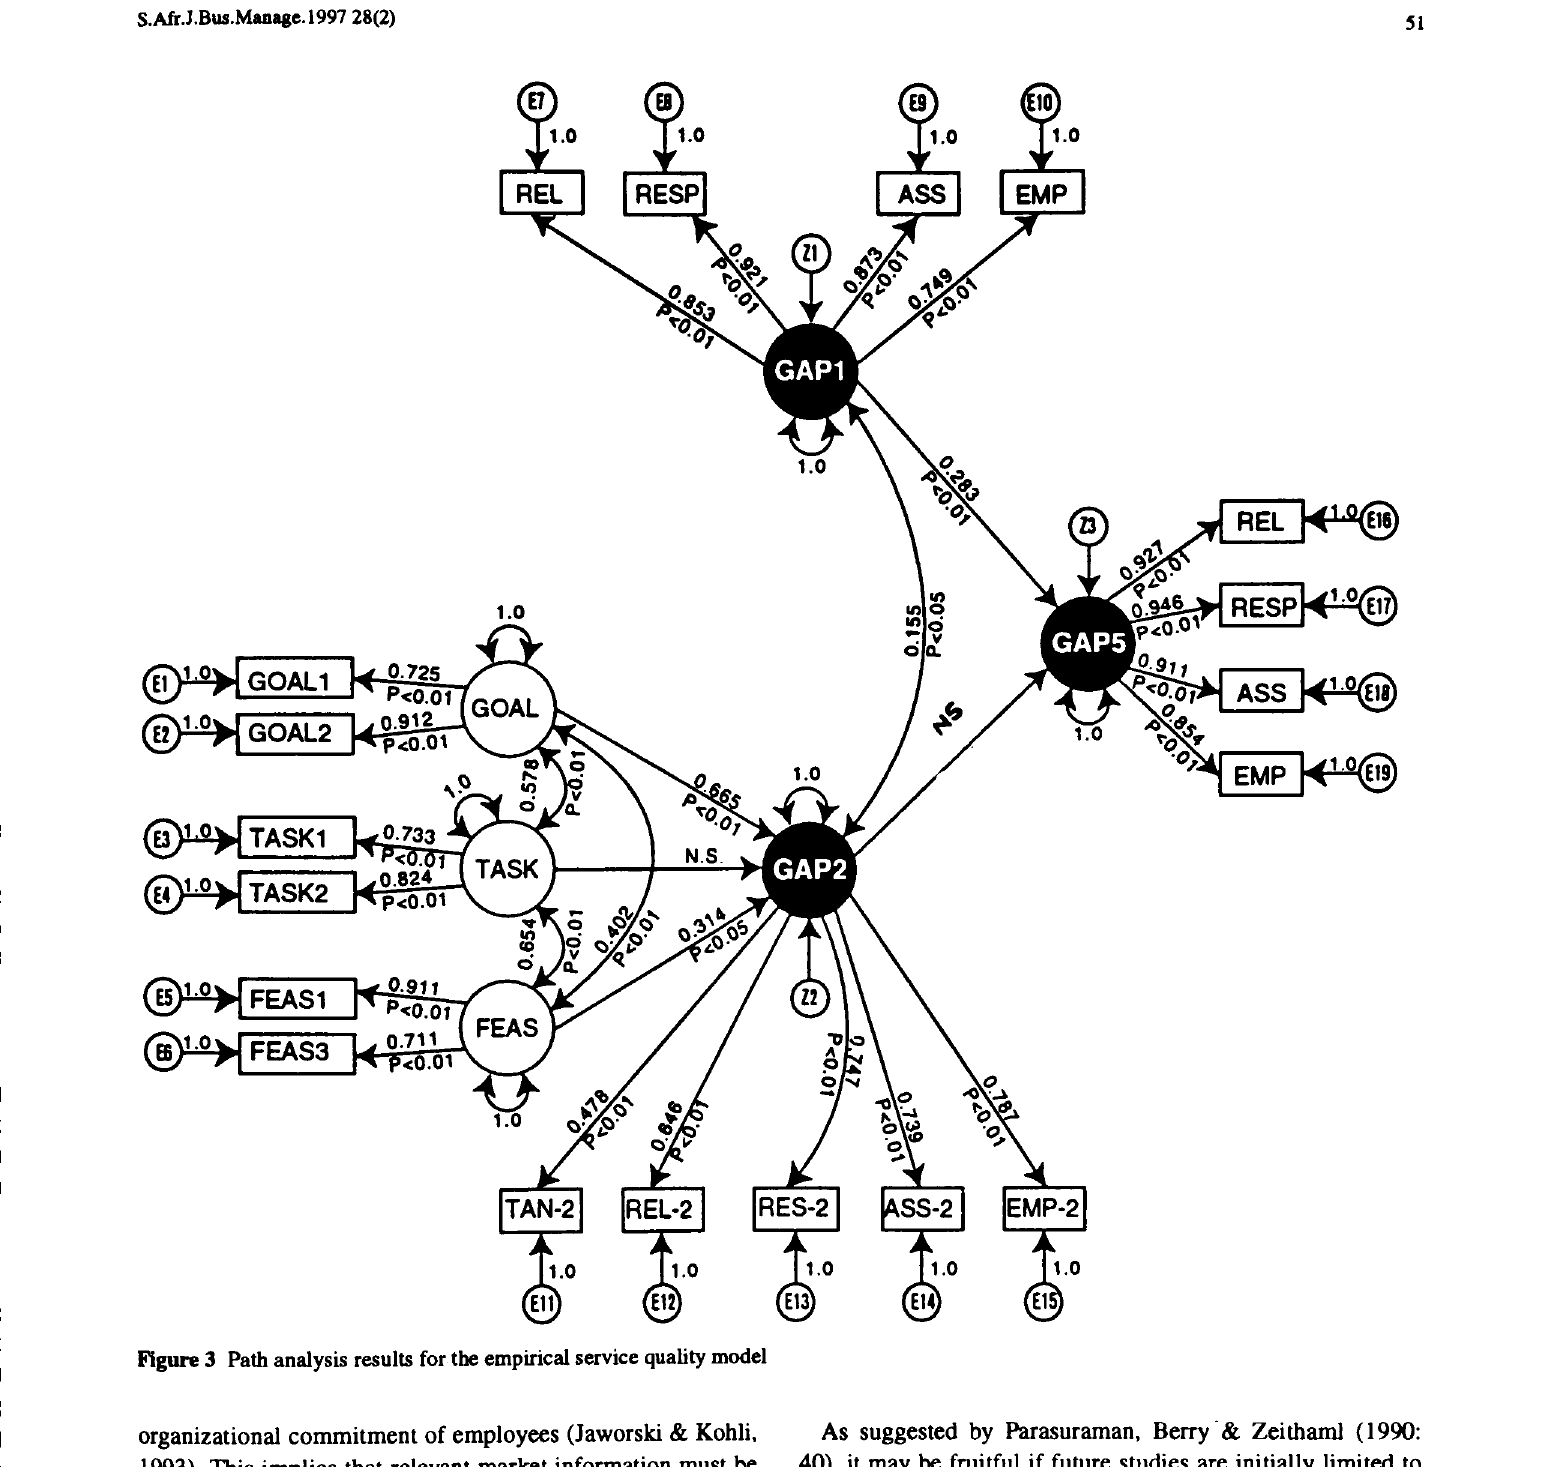
Figure 3 Path analysis results for the empirical service quality model organizational commitment of employees (Jaworski &